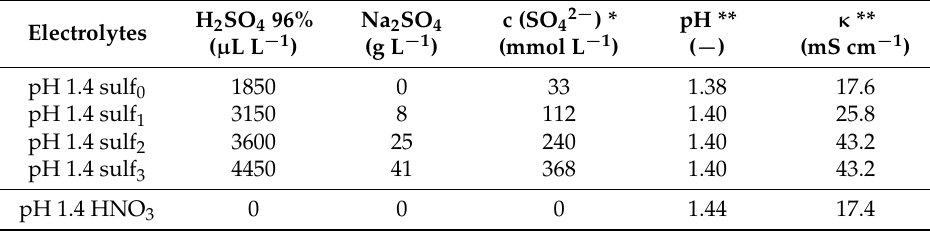
Table 1. Composition of all used